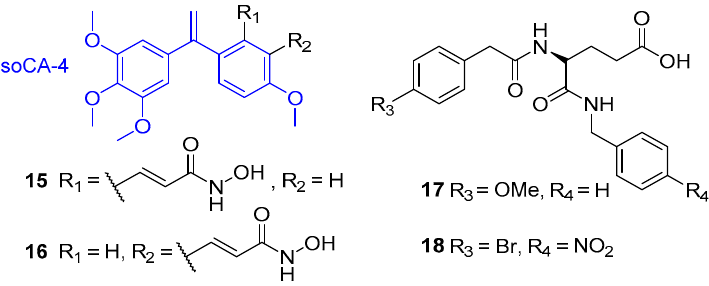
Figure 6. HDAC8-selective dual HDAC inhibitors.